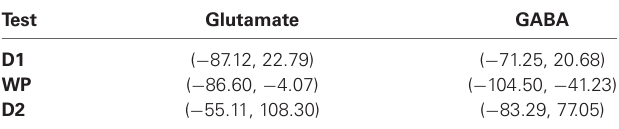
Table 2 | 95% confidence intervals of percent change of neurotransmitter from baseline for each memory test .